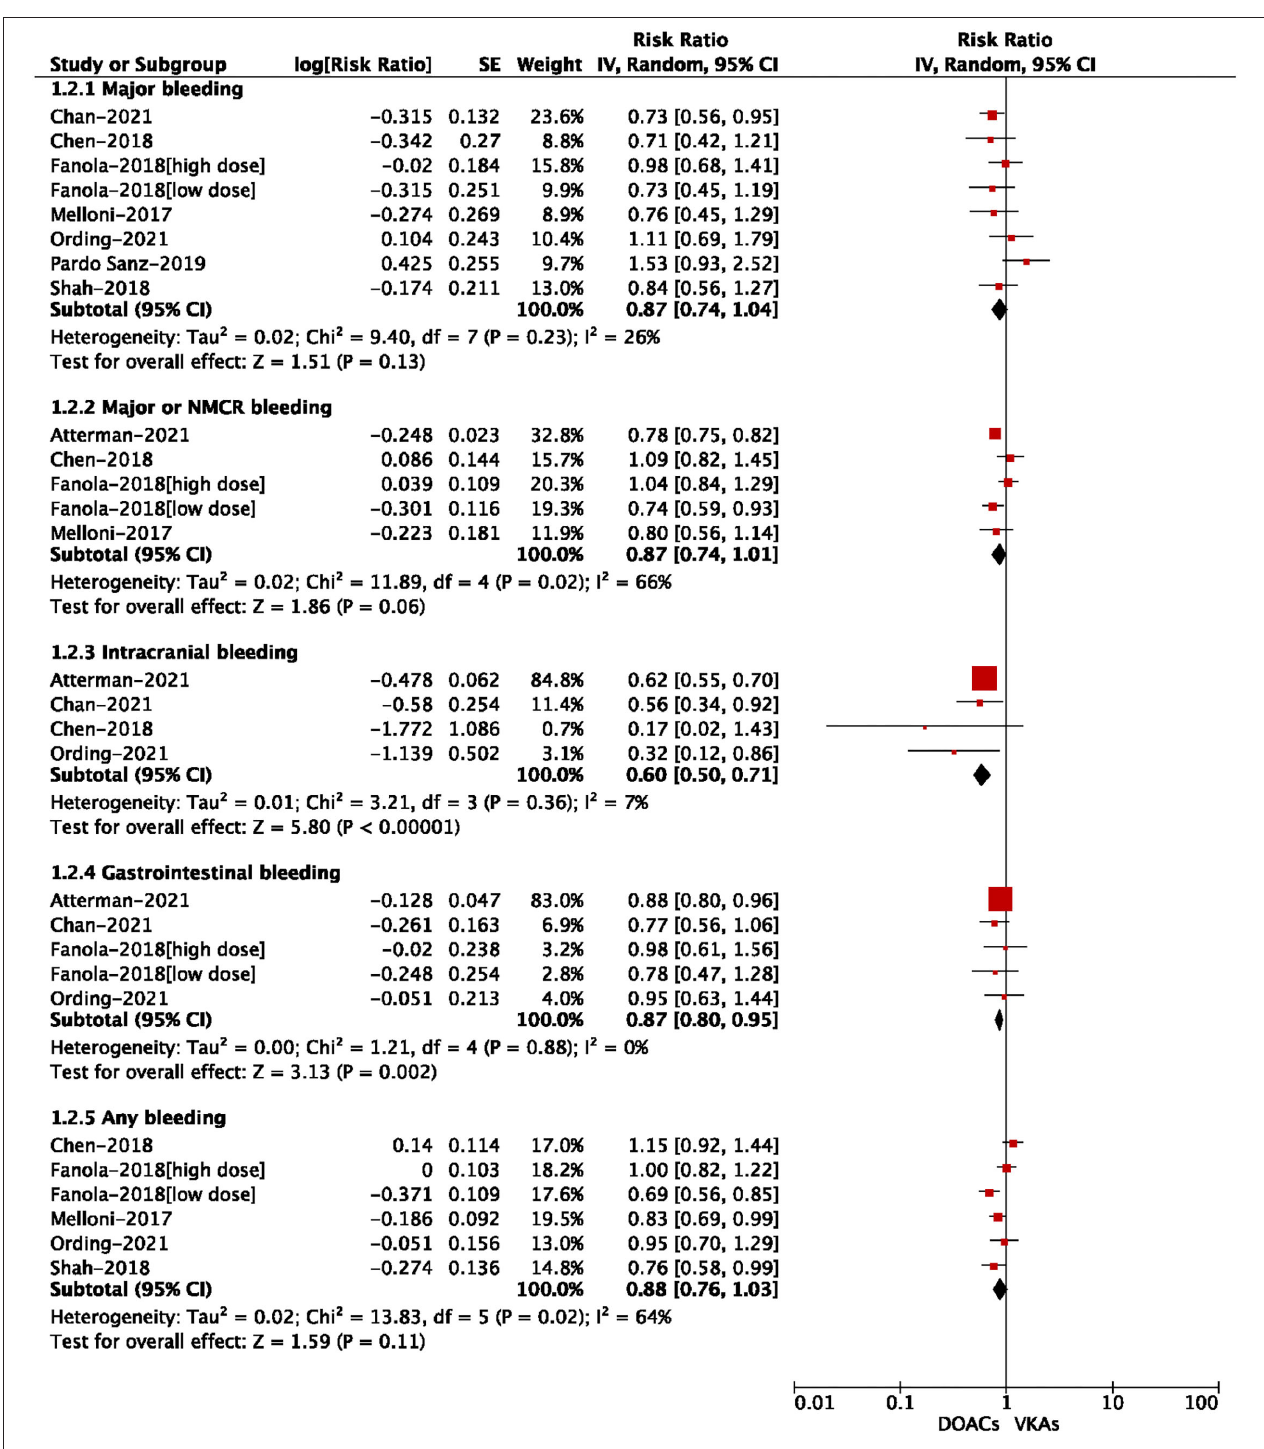
FIGURE 4 | Adjusted safety data of direct oral anticoagulants compared with vitamin K antagonists among atrial fibrillation patients with cancer.